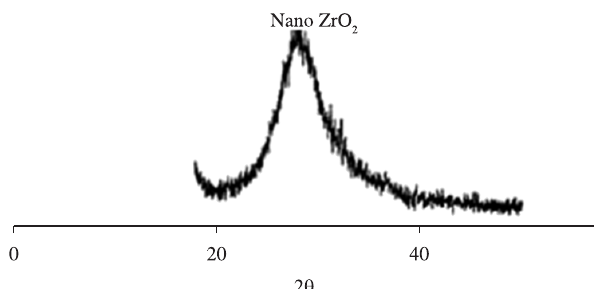
Figure 3. XRD analysis of ZrO